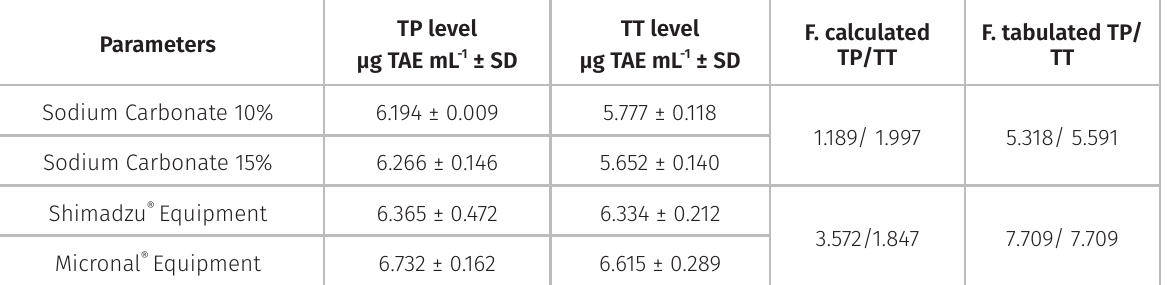
F. tabulated TP/ TT